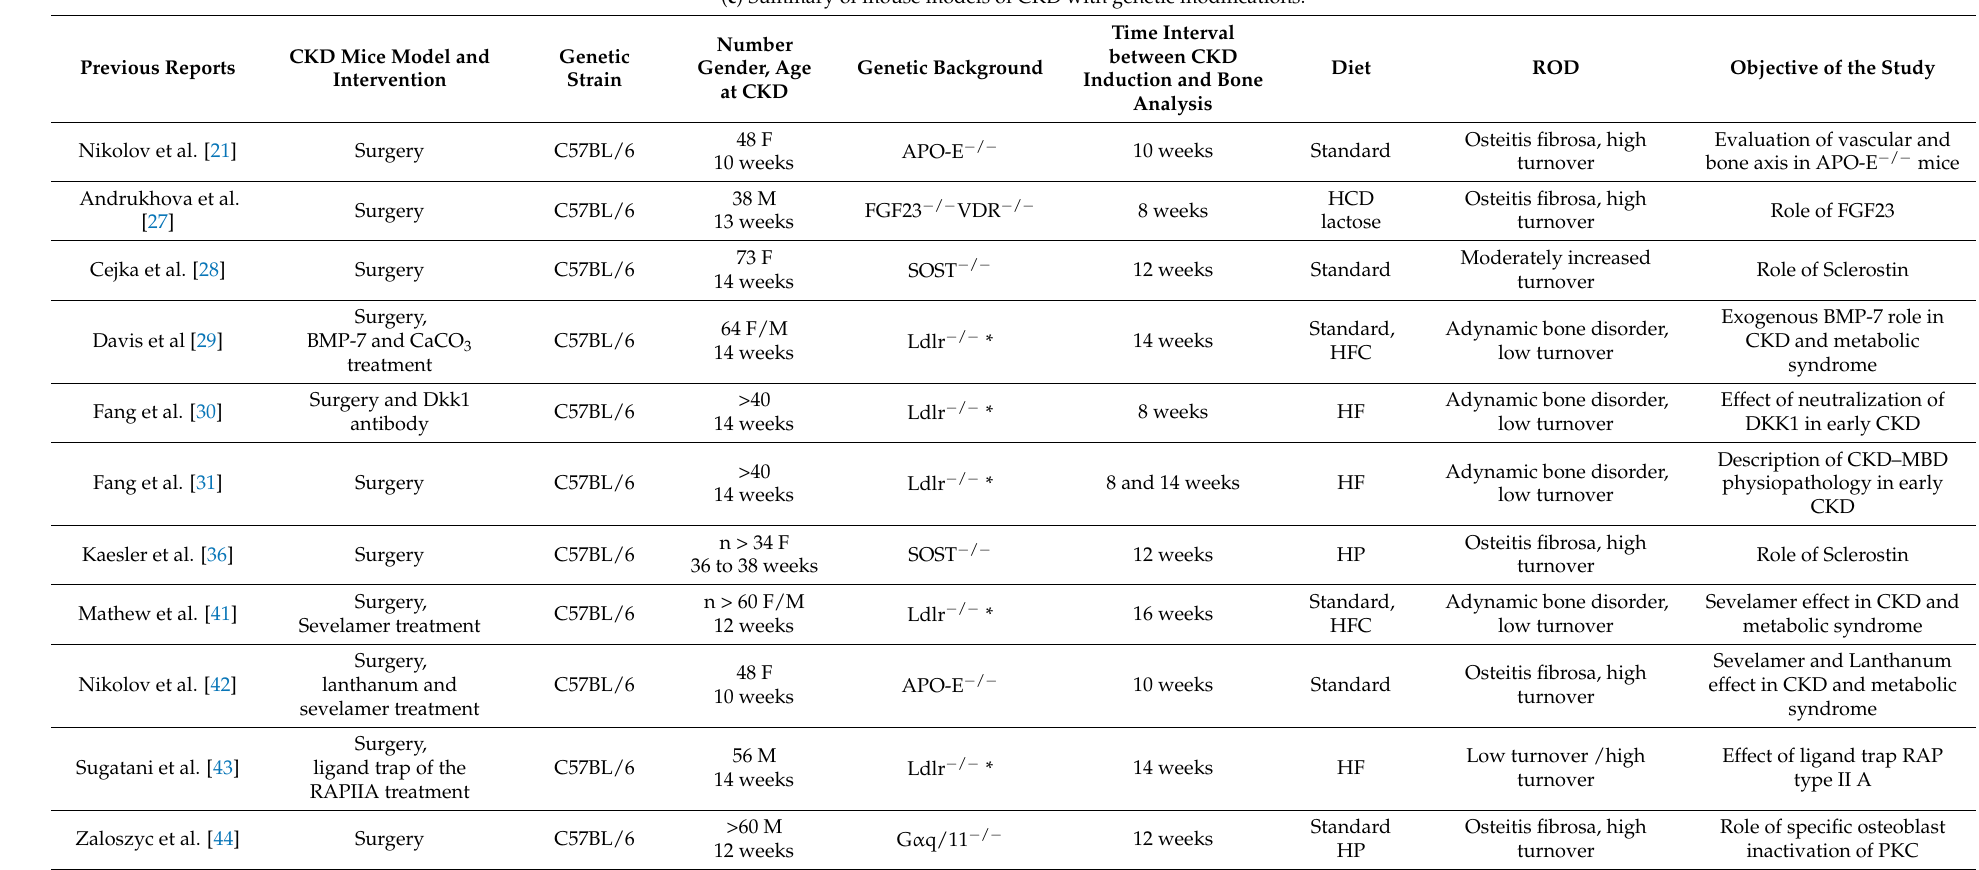
Table 1. Cont. ( c ) Summary of mouse models of CKD with genetic